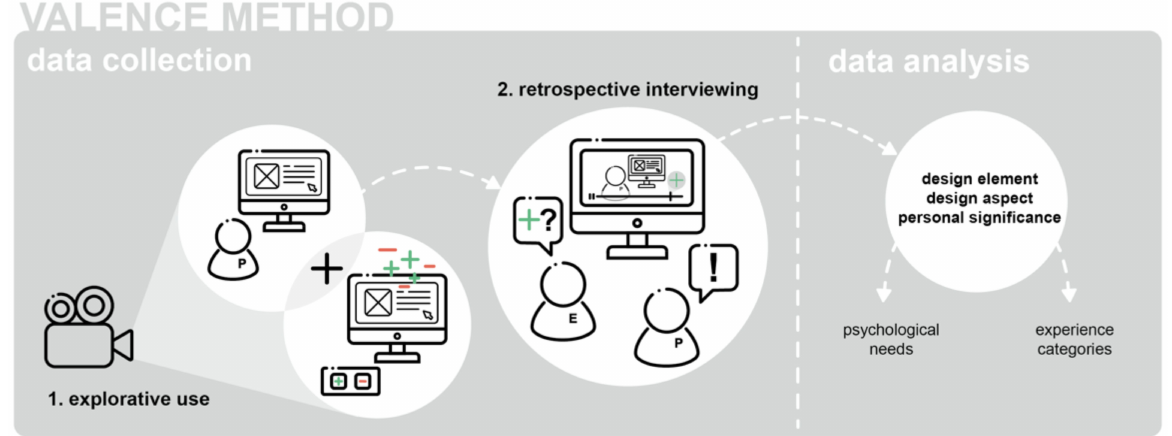
Figure 2. Schematic procedure of the valence method. Green plus signs represent positive valence markers; red minus signs represent negative valence markers. P, participant; E, experimenter.